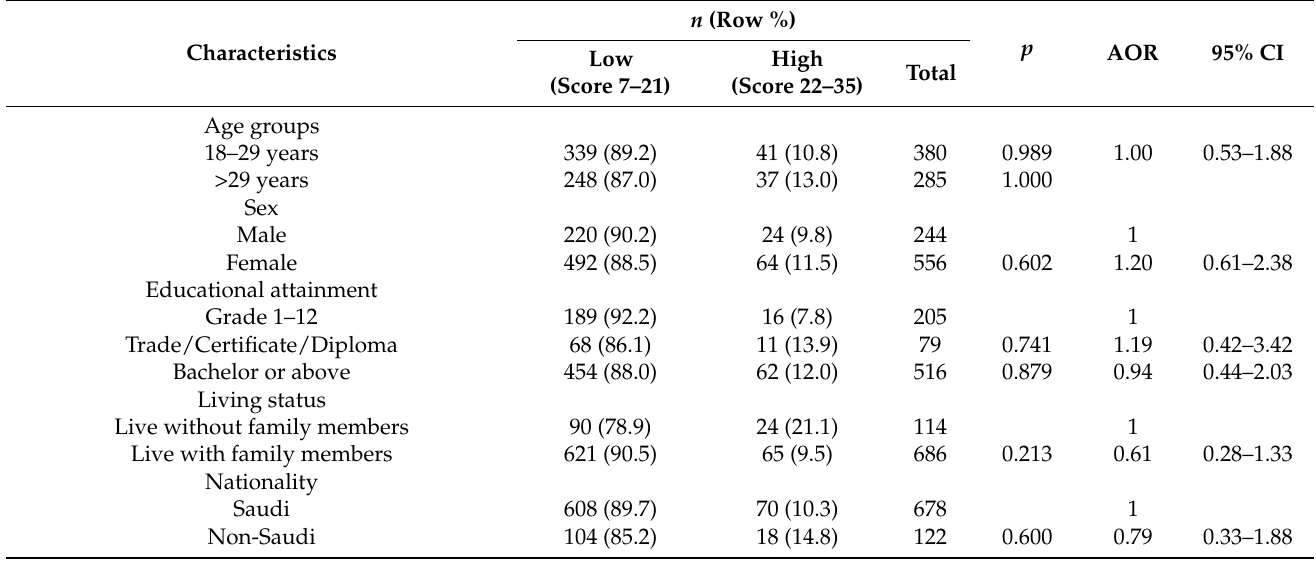
Table 5. Factors associated with the fear of COVID-19 among adults in Saudi